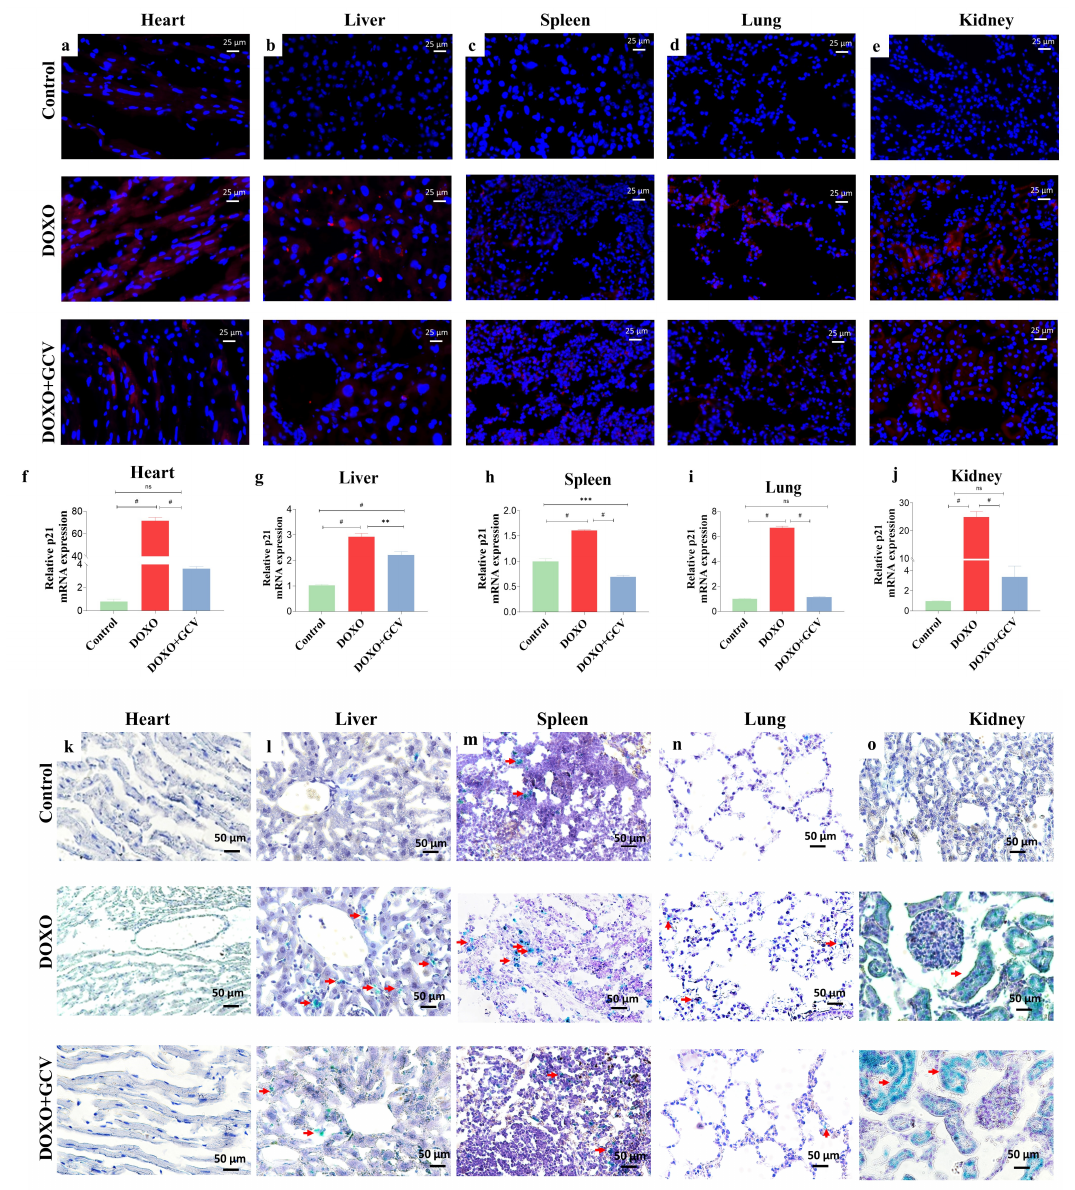
Figure 3. GCV counteracts the expression of senescence markers in vital organs. ( a – e ) Representative micrographs of 5 vital organs in p21-3MR mice from control/DOXO, and DOXO+GCV groups. ( f – j ) Representative p21 mRNA expression level of 5 vital organs in p21-3MR mice from control/DOXO, and DOXO+GCV groups. ( k – o ) Representative SA- β -gal activity of 5 vital organs in p21-3MR mice from control/DOXO, and DOXO+GCV groups. Red: mRFP, Blue: DAPI, Red arrow: senescent cells. **, p < 0.01. ***, p < 0.01. #, p < 0.0001, ns, no significant. Experiments were repeated in 3 mice. One-way ANOVA with Bonferroni correction for multiple